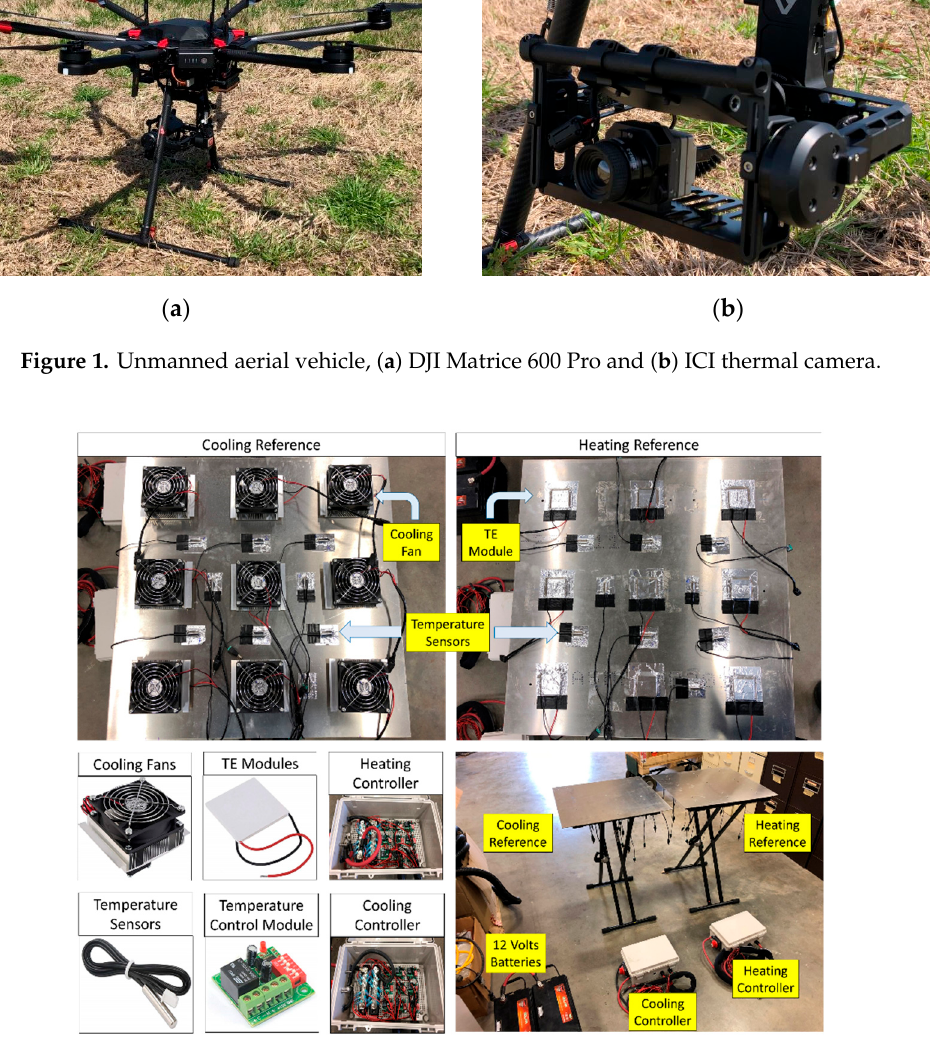
Figure 2. Individual components of the controlled high- and low-temperature references.